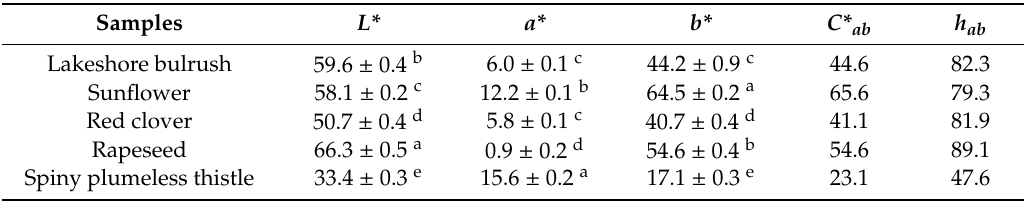
Table 2. The L* , a *, b *, C* ab and h ab values of bee pollen samples.